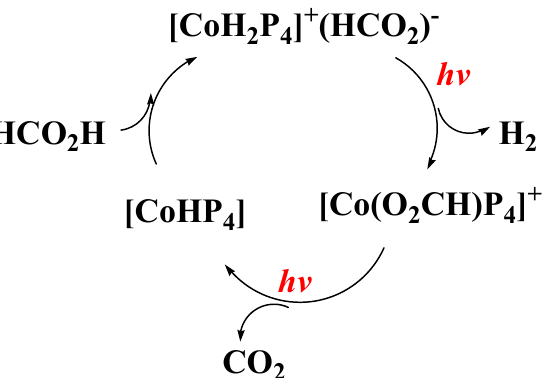
Figure 10. Catalytic cycle for FA dehydrogenation-assisted multiple-photons mechanism. Figure adapted from Reference [59].